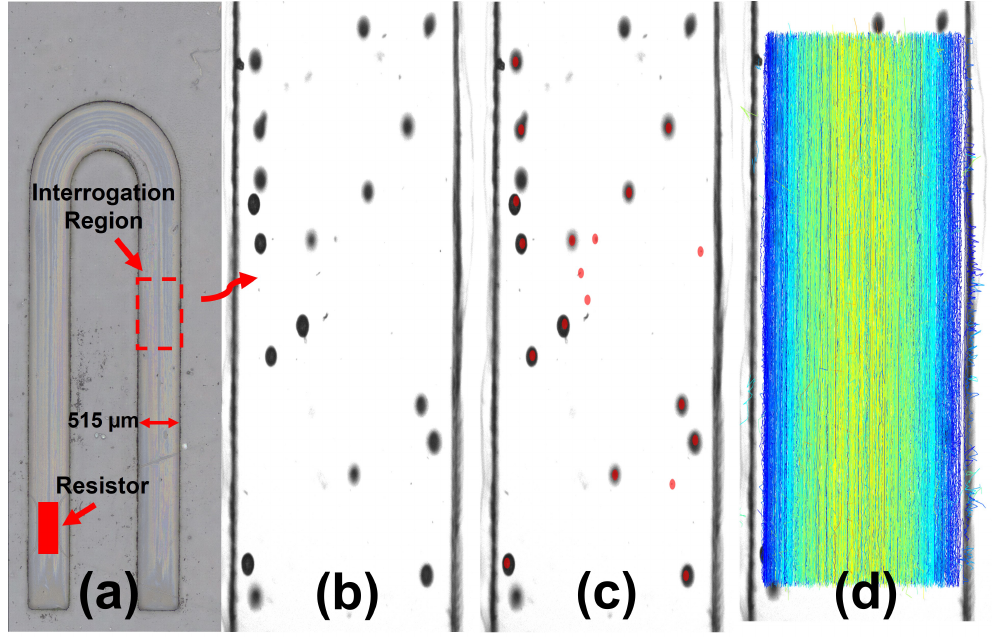
Figure 6. Particle Tracking Process—describes the particle tracking process. ( a ) shows a dry milli- channel of cross-section A = 515 × 315 µ m 2 and length L = 13.268 mm with a 300 × 700 µ m 2 TMP resistor placed 1027 µ m from the reservoir edge. ( b ) shows neutrally buoyant micro-spheres with a diameter of D = 27–32 µ m in a channel filled with water. A MATLAB implementation of the interactive data language, IDL, particle tracking software is used to mark particles ( c ) and link particle movement into trajectories ( d ). Particle trajectories are colored in accordance to average velocity in which the fastest moving particles (shown in yellow with a velocity of 19.2 µ m/pulse) are near the center of the channel while the slowest (shown in blue with a velocity of less than 1 µ m/pulse) are towards the